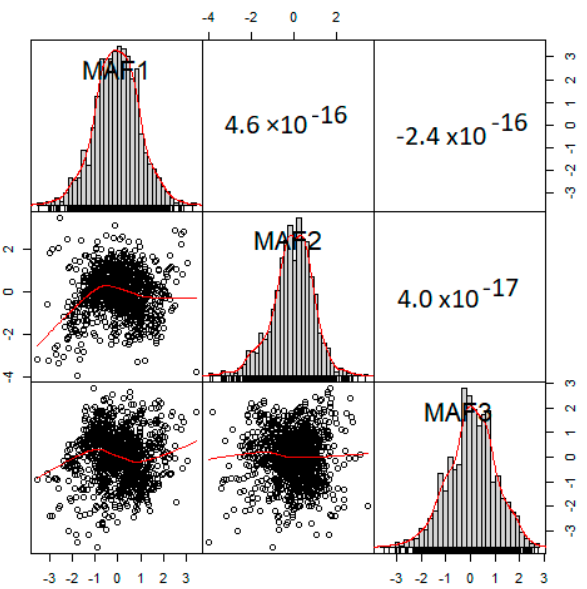
Figure 8. Correlation matrix plot showing a lack of correlation between the minimum and maximum autocorrelation factors.